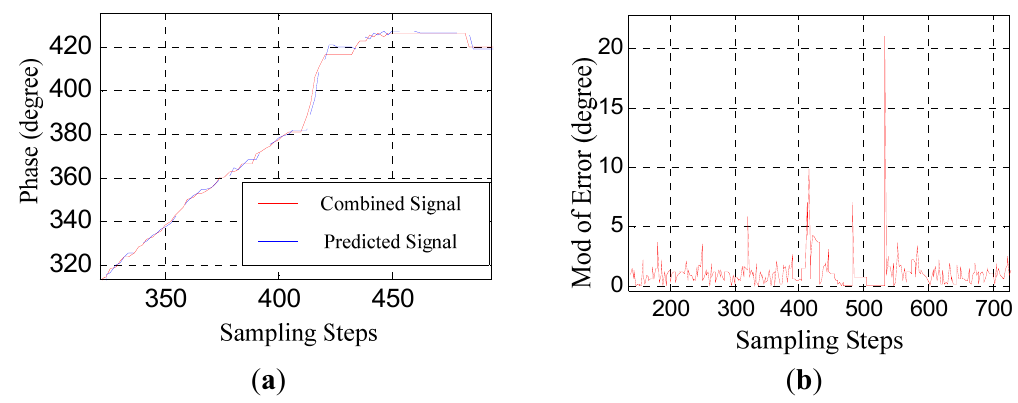
Figure 6. ( a ) The predicted phase signal; ( b ) The prediction